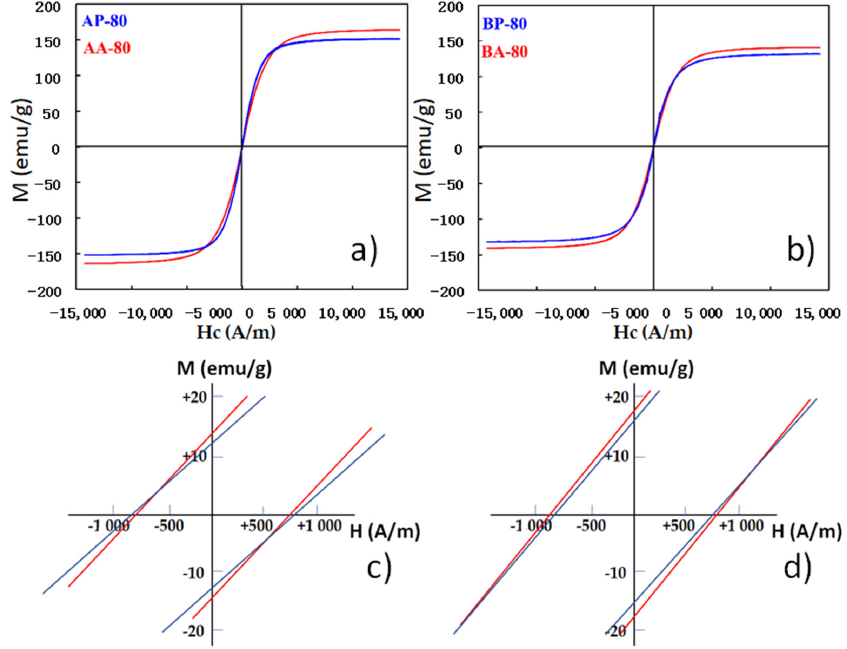
Figure 9. Magnetic hysteresis loops of samples: ( a ) AP-80, AA-80, ( b ) BP-80 and BA-80 and insets of the (0,0 region), ( c ). AP-80, AA-80, ( d ) BP-80 and BA-80.